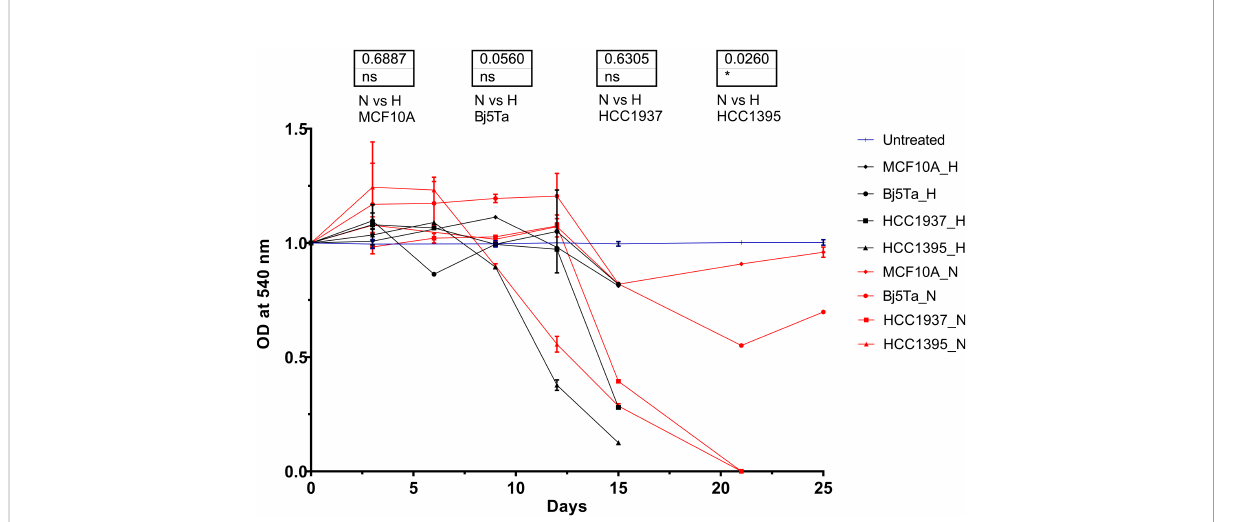
FIGURE 2 Cell growth rate during the radiotherapy evaluated in the MTT assay. OD values for each cell line were normalized to the appropriate values of untreated cells and plotted versus the irradiation day. The blue lines represent untreated values of the individual cell lines at speci fi c experimental days, which were normalized to 1. The red lines correspond to the HypoRT protocol and black lines to the NormRT protocol, respectively. *p<0.05, n.s, non-signi fi